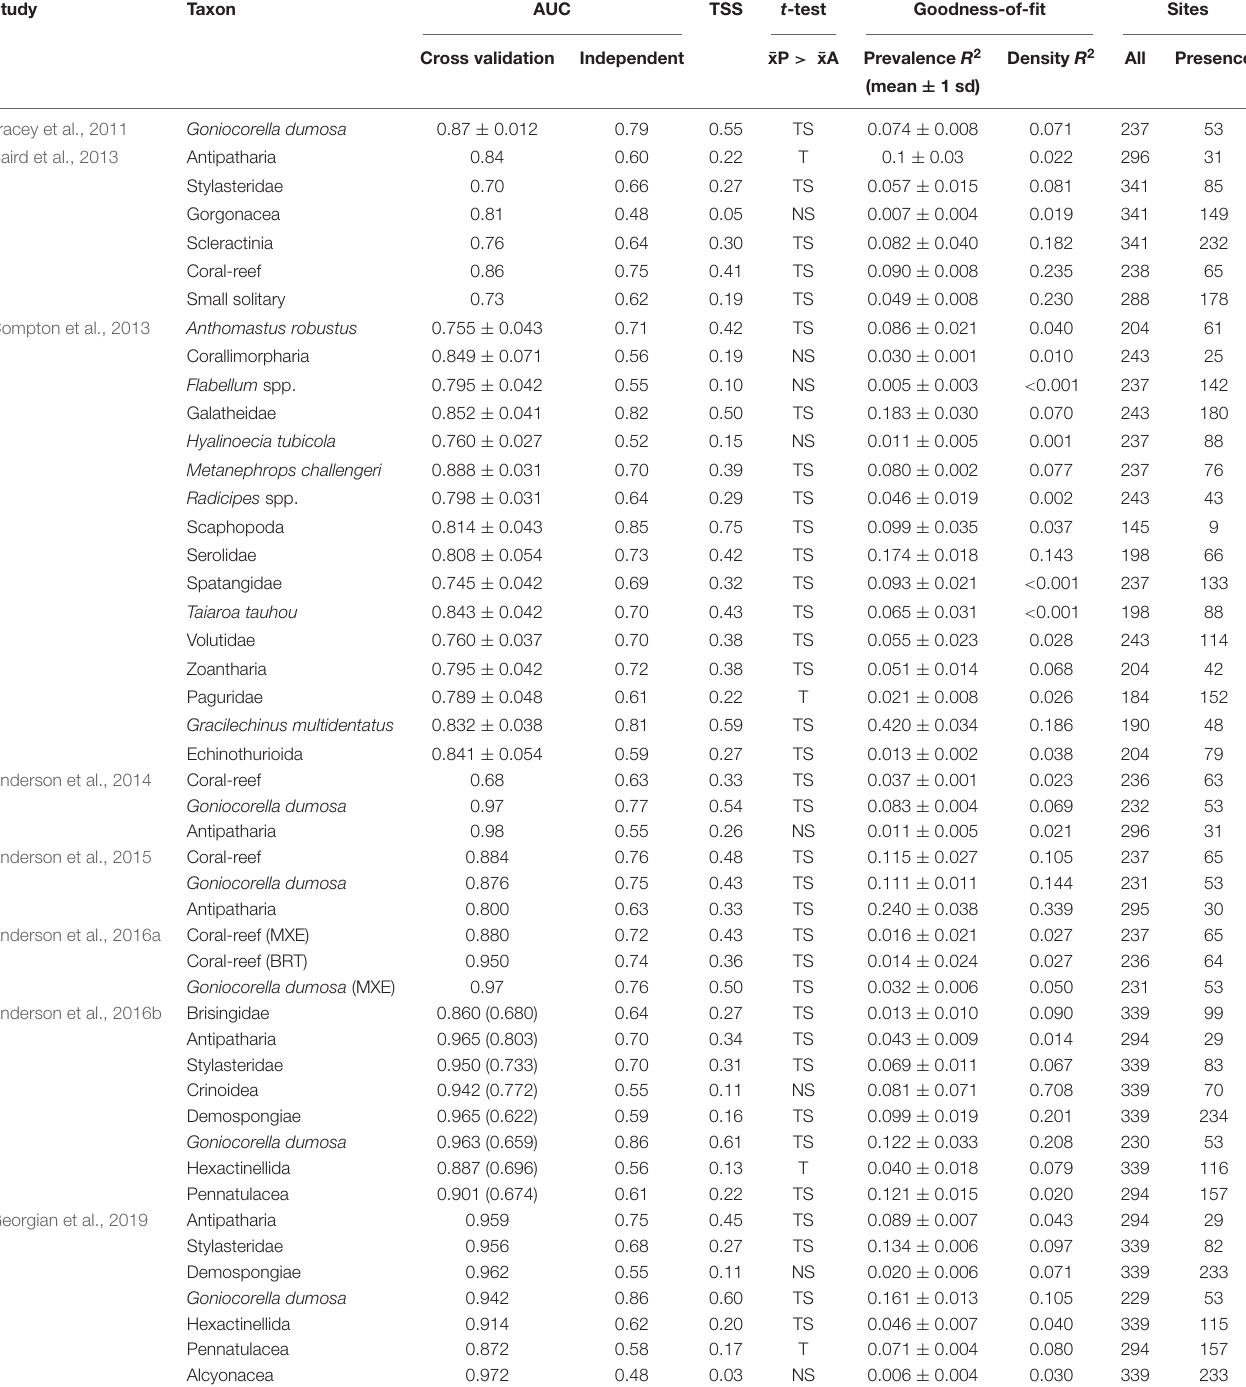
TABLE 3 | Model assessment